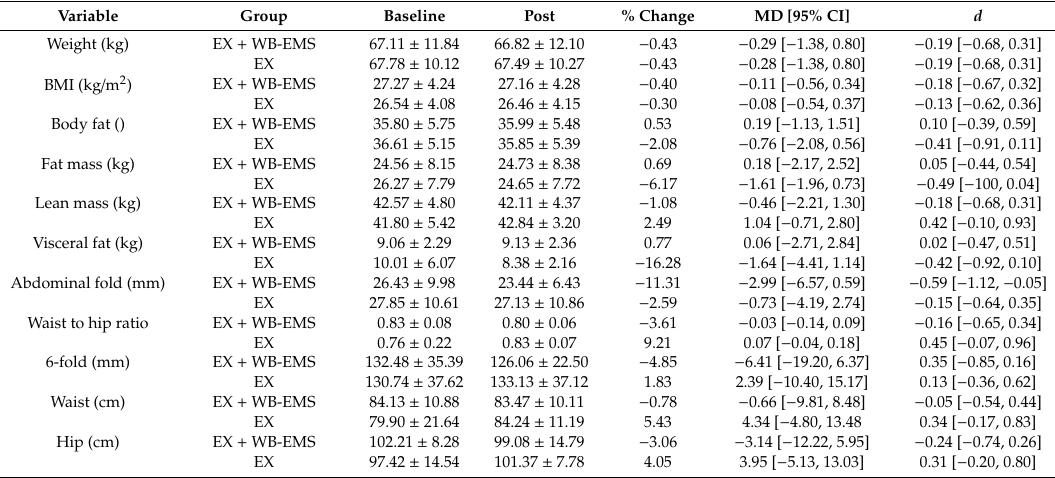
Table 2. Summary of baseline and postintervention data of the body composition variables for each group EX + WB-EMS ( n = 16) and EX ( n =